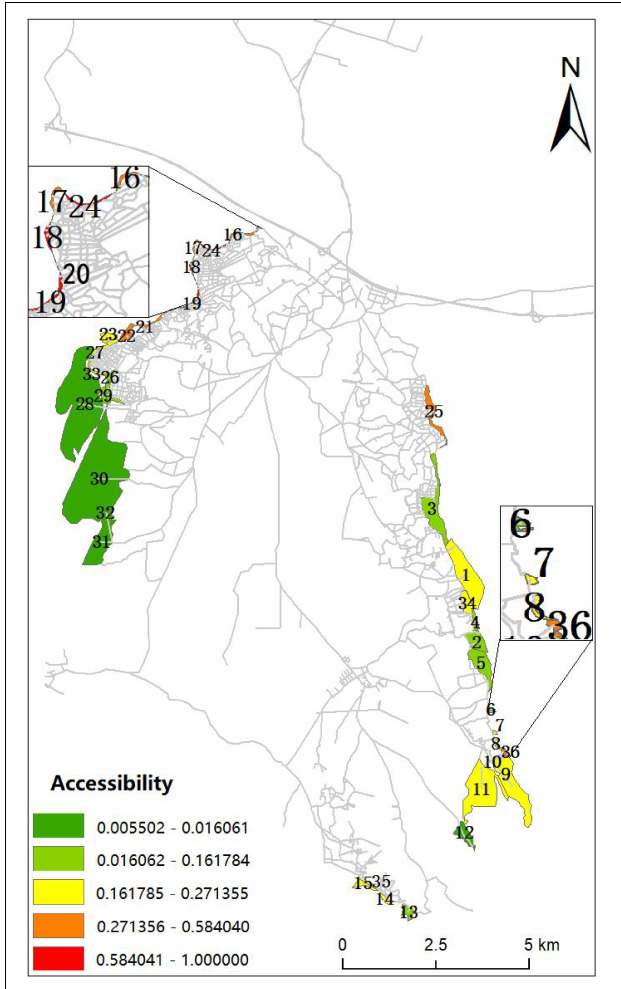
FIGURE 11 | Accessibility calculated by the comprehensive weighted value of mangroves.